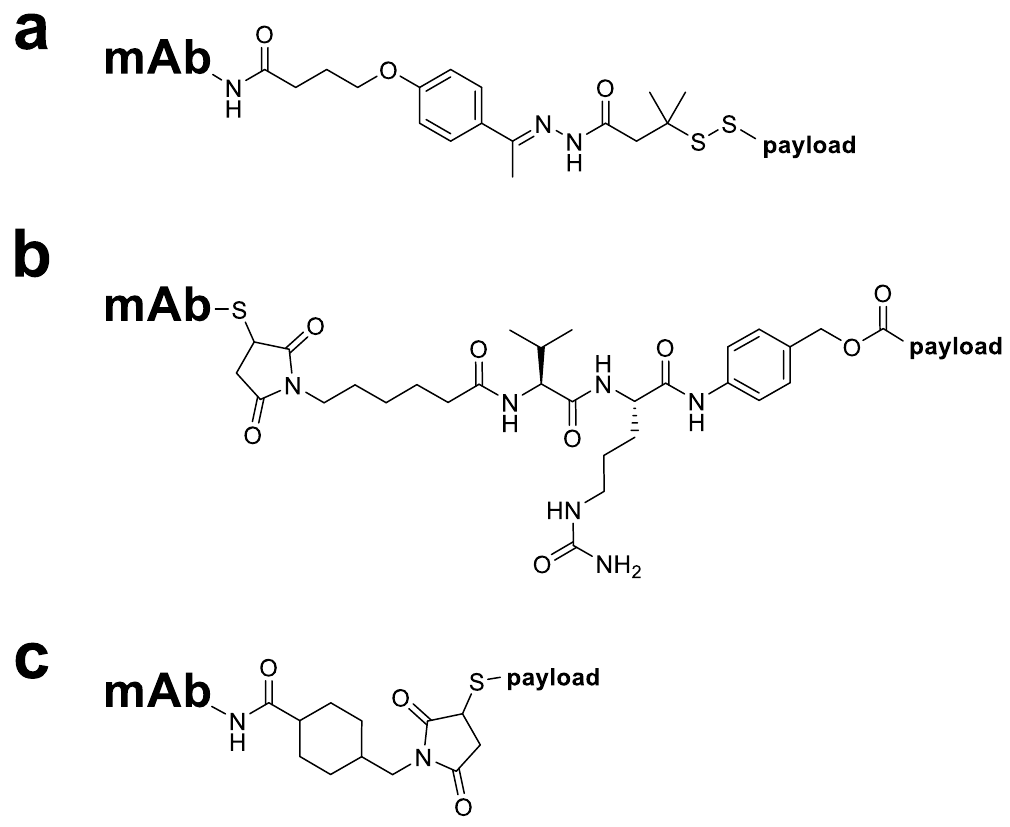
Figure 3. Structures of different linker groups used in ADCs. ( a ) A cleavable hydrazone linker and disulphide trigger as used in Mylotarg ® ; ( b ) an MC–Val–Cit–PABC linker, combining the non-cleavable MC and dipeptide cleavable Val–Cit linkers with a PABC spacer, as used in Adcetris ® ; ( c ) a non-cleavable MCC linker as used in Kadcyla ®